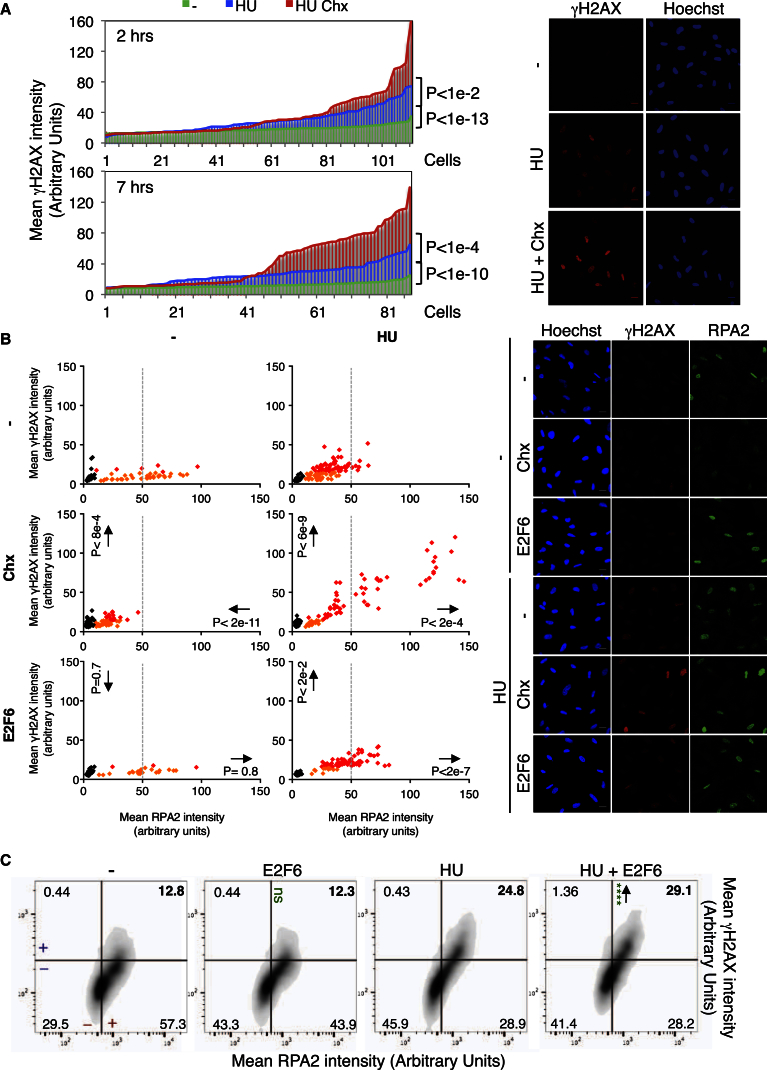
E2F Transcription and Active Protein Synthesis Are Required to Prevent RS-Induced DNA Damage(A) Graph of mean chromatin-bound γH2AX intensity of single nuclei. Treatment and times are as shown for RPE1 cells. p, significant differences of S phase cells with Wilcoxon. Representative images are from 7 hr. The scale bar represents 20 μm.(B) Scatterplot of mean intensity of chromatin-bound RPA2 versus γH2AX of single nuclei. Treatments shown for 7 hr for RPE1 TetON E2F6. E2F6 overexpression, Doxy. Black, non-S phase cells (RPA2 < 10 a.u.); orange and red dots, low and high levels of γH2AX, respectively (arbitrary threshold γH2AX = 15 a.u.). p, differences on both axes of S phase cells with Wilcoxon compared to control (−/HU as appropriate). Arrows show change in mean. Representative images are shown. The scale bar represents 20 μm.(C) Density plot of FACS for RPA2 versus γH2AX intensity; treatments shown are for 7 hr for RPE TetON E2F6 cells. Doxy, 2 μg/ml. Quadrants define RPA2 or γH2AX −/+ cells (−/+ in red and blue, respectively); percentage of cells is shown. Around 10,000 cells were collected per condition. Logarithmic scale identical for all. ∗∗∗∗p < 0.0001 compared to non-E2F6 control; Student’s t test. Arrows show change of mean.See also Figures S1 and S2.